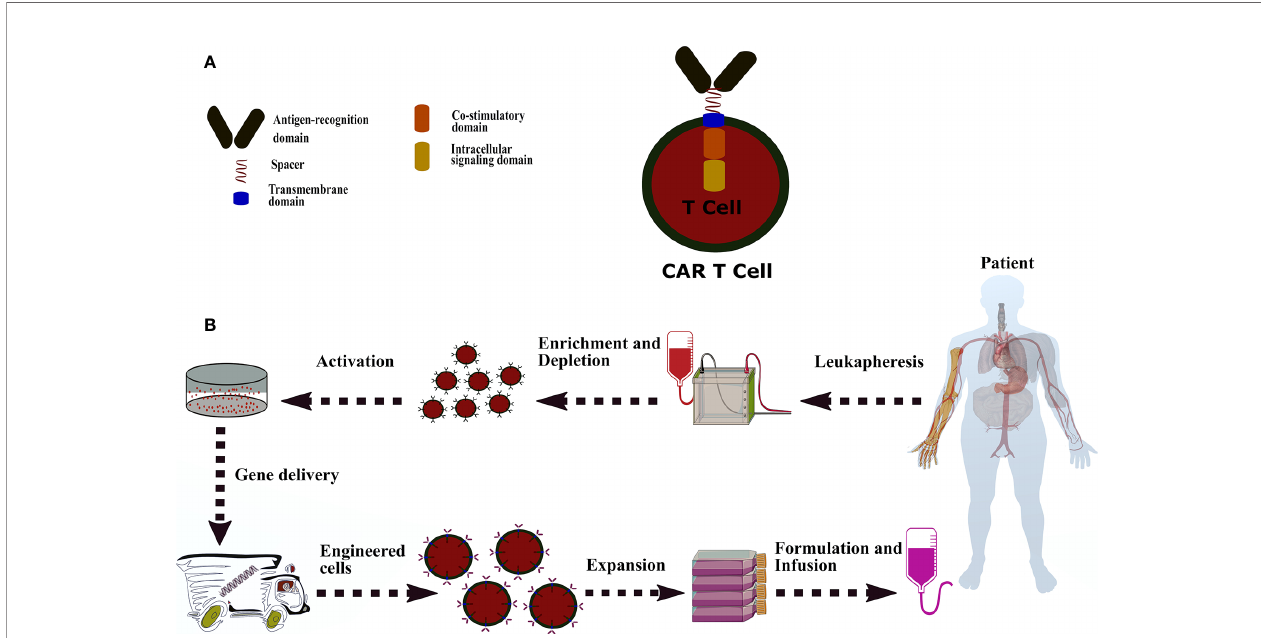
FIGURE 1 | A common CAR construction. (A) : CAR is comprised of antigen-recognition domain (scFv), a hinge domain or spacer (CD28, CD8 a , CD7, IgG4, and IgG1), a transmembrane domain (CD28, CD8 a , CD7, CD4, CD3z, and OX40), a co-stimulatory domain (CD244, CD28, CD27, OX40, ICOS, and CD137), and a signaling domain (CD3z, DAP10, and DAP12). (B) : The process of CAR-T manufacturing from peripheral blood mononuclear cells to genetically modi fi ed-T cells and administration. CAR-T therapy starts with accumulating the patient ’ s white blood cells by leukapheresis. The apheresis products are enriched or deleted for a speci fi c cell subset and then activated by one of following methods, including interleukins (IL-2, IL-7, and IL-15), anti-CD3/CD28 antibody-coated magnetic beads, soluble CD3 antibody, arti fi cial antigen-presenting cells, plate-bound antibodies, and adhesion molecules. The activated T cells are introduced with the CAR transgene through lentiviral or retroviral and non-viral methods (electroporation of naked DNA and plasmid-based transposon/transposase). Afterwards, the engineered-T cells undergo an expansion process in static culture bags or dynamic culture vessels or rotating bioreactors. Eventually, cell numbers are calculated based on the patient ’ s disease burden, weight, and another formulation. The CAR modi fi ed-T cells transfer to either a container for infusion purposes or cryopreserved for